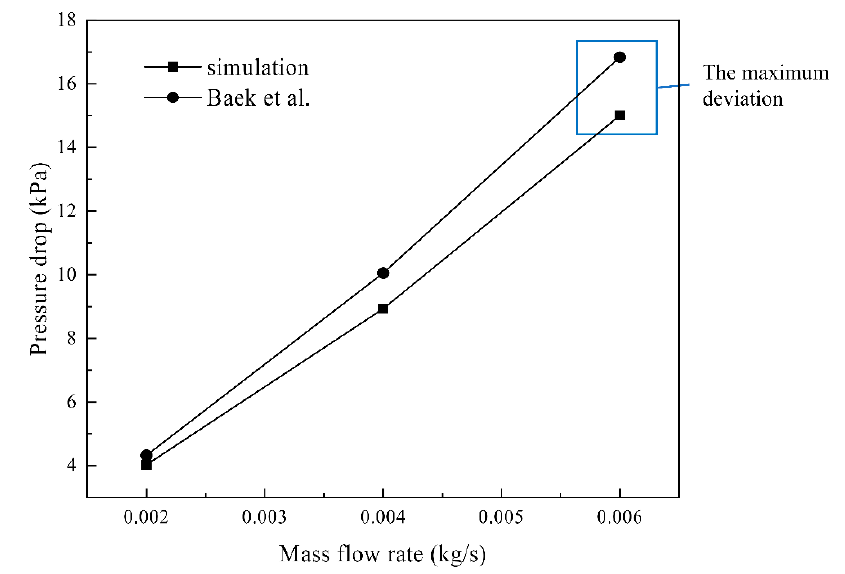
Figure 5. Model verification [36].